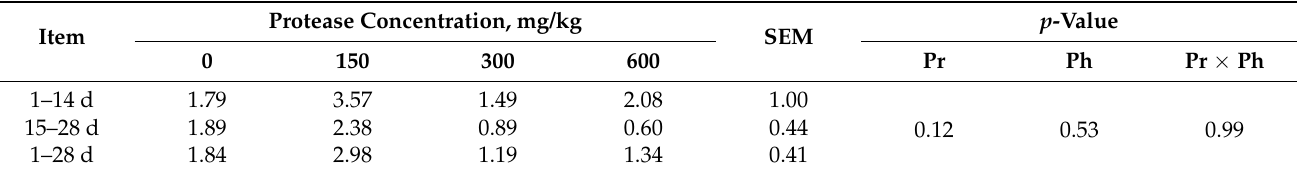
Table 4. Effects of protease supplementation on diarrhea rate in weaned